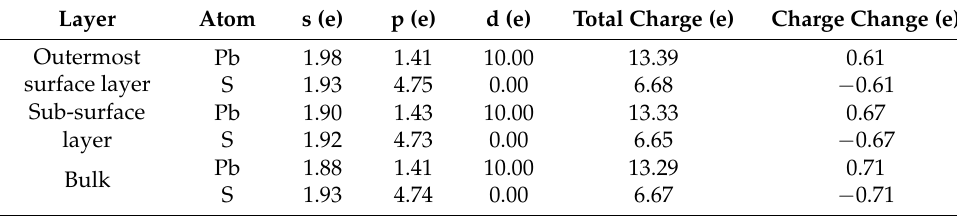
Table 7. Mulliken charge of galena (100) surface after relaxation.